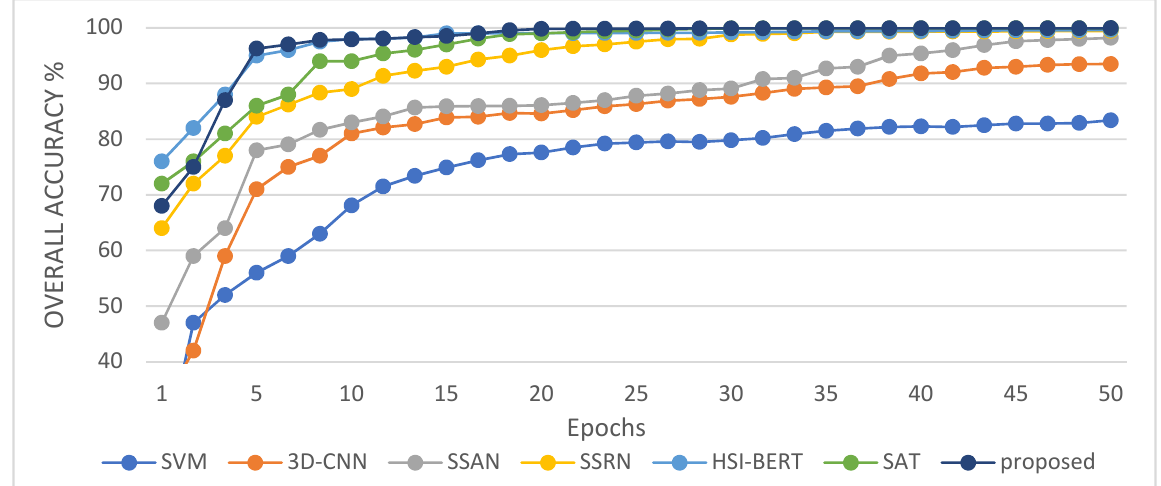
Figure 11. Overall accuracy curve of different models in SA dataset.